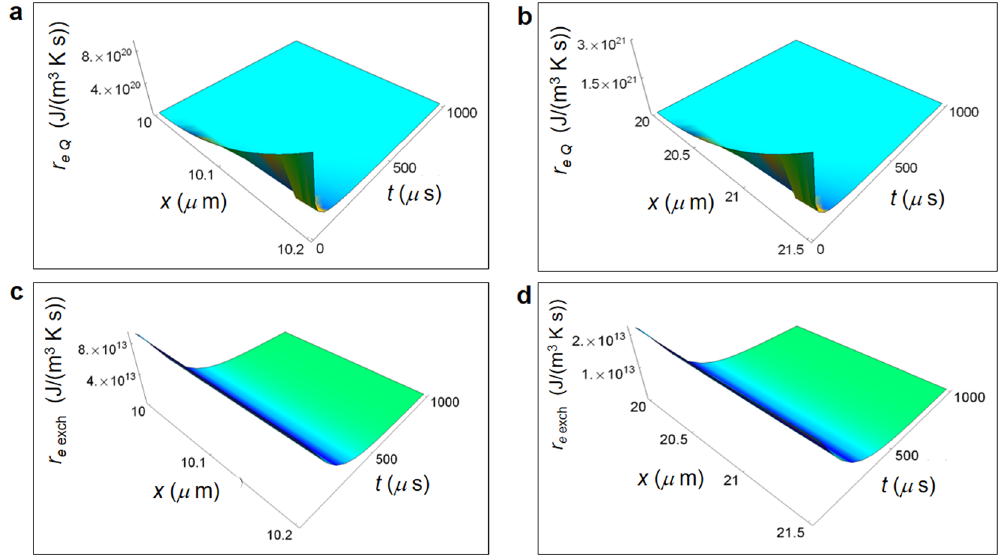
Figure 3. Calculated REEDP during glucose catabolism for a breast cell. ( a) REEDP associated to heat flow for a normal cell as a function of the spatial and time coordinates. ( b ) REEDP associated to heat flow for a cancer cell. ( c) REEDP due to exchange of matter for a normal cell. ( d) REEDP due to exchange of matter for a cancer